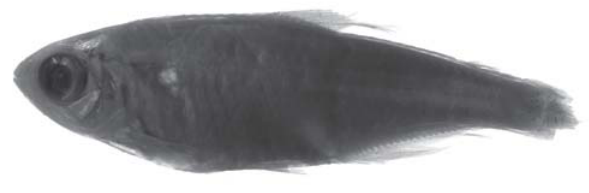
Fig. 8. Holotype of Odontostilbe caquetae , ANSP 70495, unsexed 28.0 mm